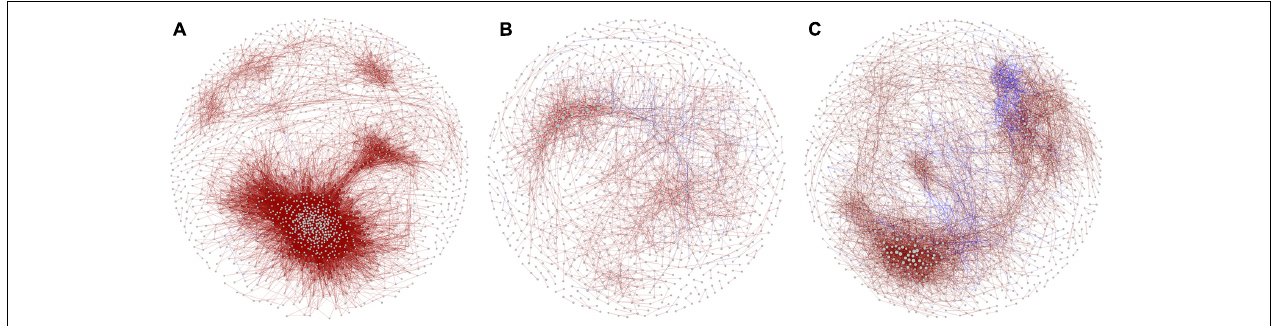
FIGURE 4 | Co-occurrence networks of benthic bacterial communities in the purification area of the IPRS at the (A) initial, (B) middle, and (C) final stages of the culture cycle.